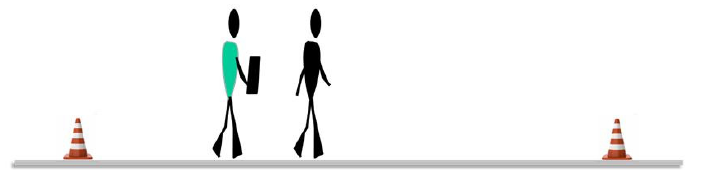
Figure 5. Walking Test at Normal Speed Over 4 Metres (reproduced with permission from Erika Meléndez-Oliva 2020) [43].